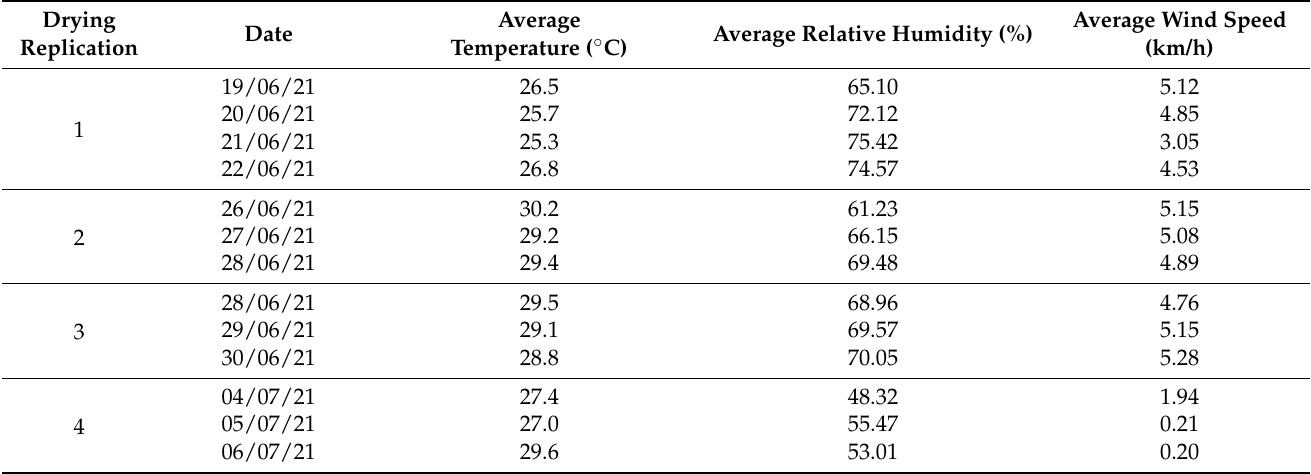
Table 4. Daily average of the temperature, relative humidity, and wind speed (9 m above the ground) of the environment outside of the greenhouse during the experimental